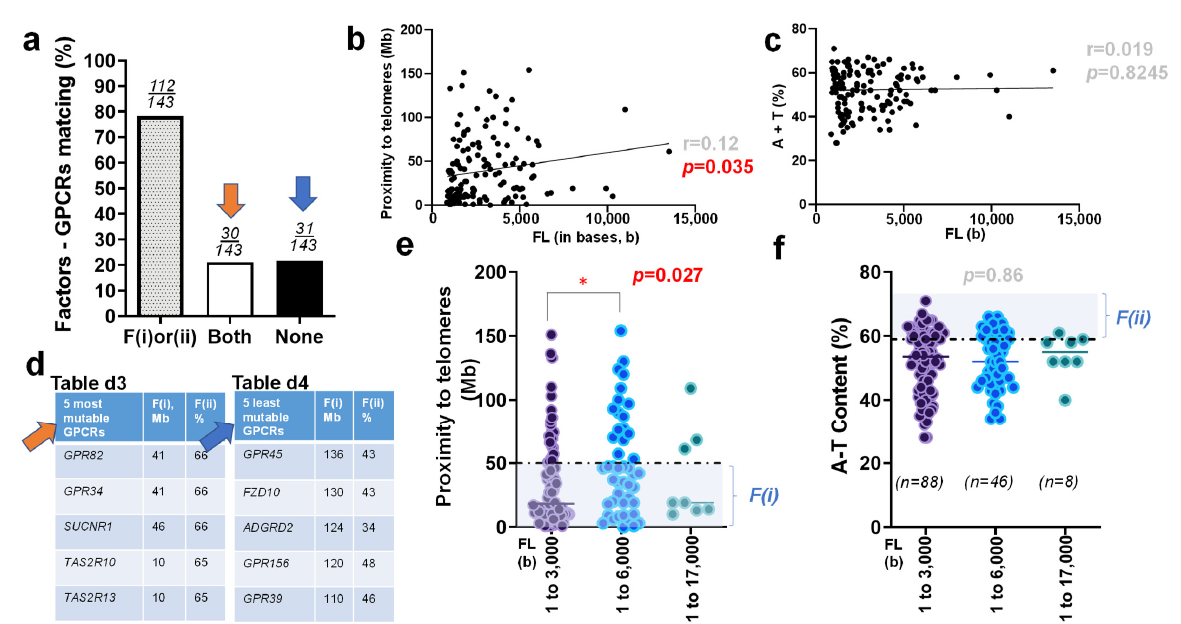
Figure 3. Relative mutability of druggable GPCRs by two factors ( a ) Bar graph, which summarizes the matching rate of genes that encode 143 druggable GPCRs with their F(i), proximity to telomeres and F(ii), their A+T content. Genes are divided into three groups: those that meet one of the two factors, (F(i) or (ii)), those that satisfy both F(i) and F(ii) (Both, denoted with orange arrow), and those that meet neither F(i) nor F(ii) (None, denoted with blue arrow) ( b ) Scatter plot that exhibits the relationship between the full-length size of genes that encode GPCRs and their associated proximity to telomeres. Statistical analysis resulted in a Pearson correlation coefficient of r = 0.12, with a level of statistical significance of p = 0.035. ( c ) Scatter plot that displays the relationship between the full length of genes that encode GPCRs and their A+T content. The Pearson correlation coefficient was determined to be r = 0.019, while the level of statistical significance was p = 0.8245. ( d ) Five primary candidates ( GPR82, GPR34, SUCNR1, TAS2R10 , and TAS2R13 ) that have been sorted as genes with relatively high mutability (the ‘Both’ group; Table d3). Moreover, five other candidate genes ( GPR45, FZD10, ADGRD2, GPR156 , and GPR39 ) have been sorted as genes with relatively low mutability (the ‘None’ group; Table d4). ( e ) Scatter plot showcasing the proximity to telomeres of genes encoding 143 GPCRs, which have been divided into three sub-groups by the full-length size of their gene (bp). A dotted horizontal line demarcates 50 Mb. A statistically significant difference between the smallest (1 to 3000 bp) and intermediate size groups (3001 to 6000 b) was determined as p = 0.027 ( f ) Scatter plot indicating the relationship between the A+T content of genes encoding 143 GPCRs with respect to the full-length of each of the genes. A dotted horizontal line demarcates 59%. No significant difference was found among any of these groups. * p <